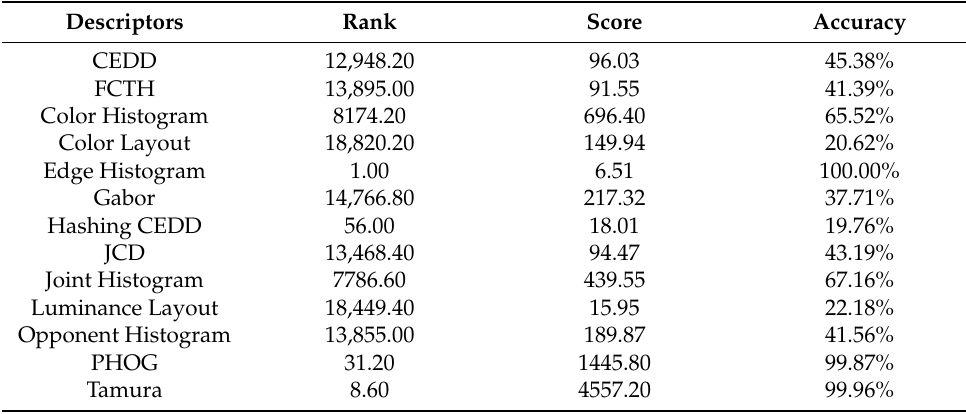
Figure 13. Average accuracy of retrieving inverted face images. Table 5. Descriptors’ performance for retrieving inverted face images.